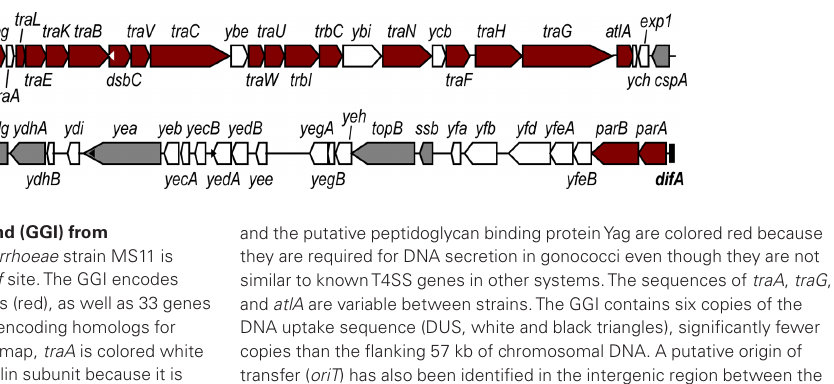
and the putative peptidoglycan binding protein Yag are colored red because they are required for DNA secretion in gonococci even though they are not similar to known T4SS genes in other systems. The sequences of traA , traG , and atlA are variable between strains. The GGI contains six copies of the DNA uptake sequence (DUS, white and black triangles), significantly fewer copies than the flanking 57 kb of chromosomal DNA. A putative origin of transfer ( oriT ) has also been identified in the intergenic region between the yaf and ltgX